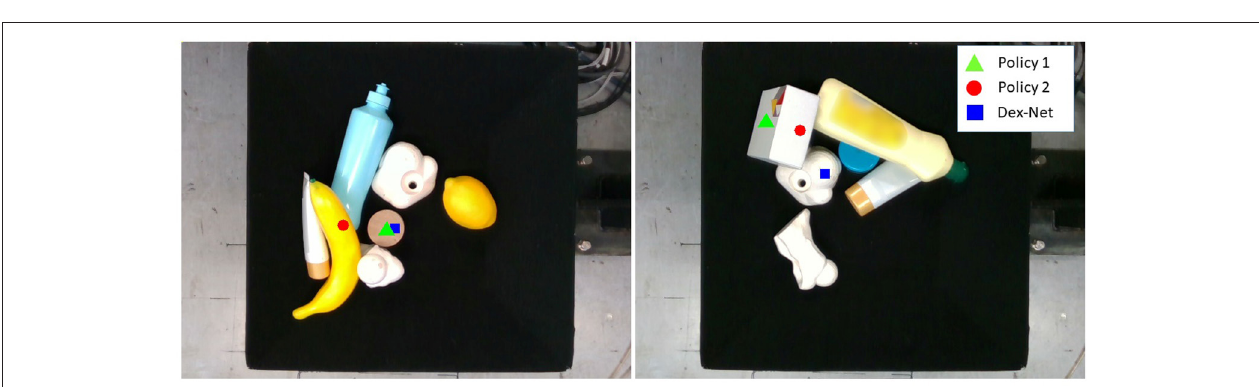
FIGURE 6 | Example of Dex-Net grasp prediction that is farther from the center of mass of the object.